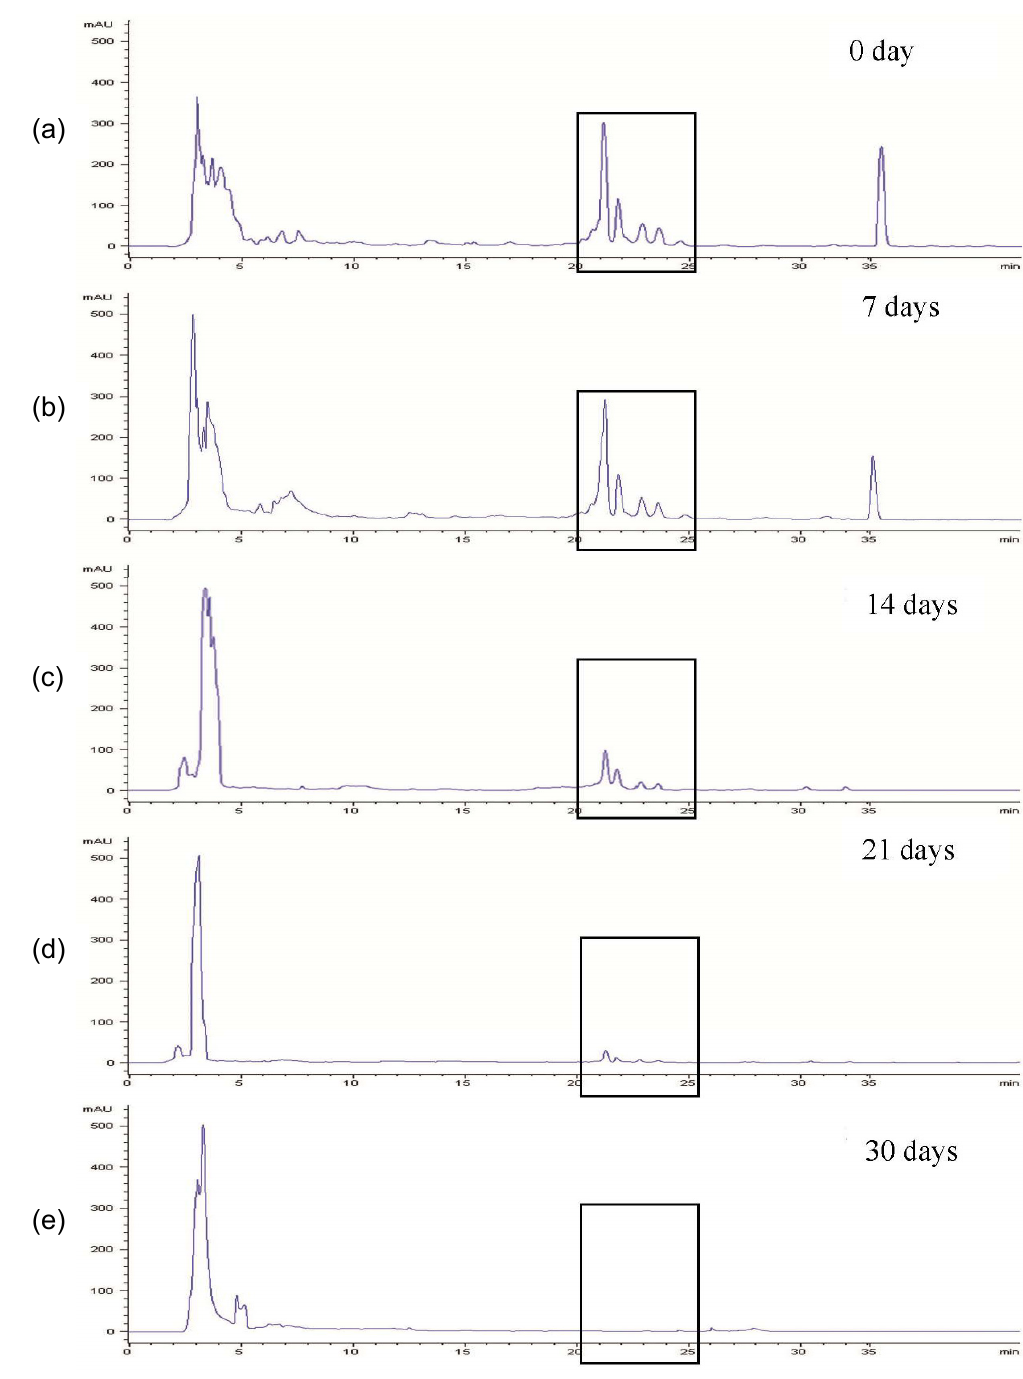
Figure 3. The HPLC chromatogram of phorbol esters treated with T. harzianum JQ350879.1 at different incubation